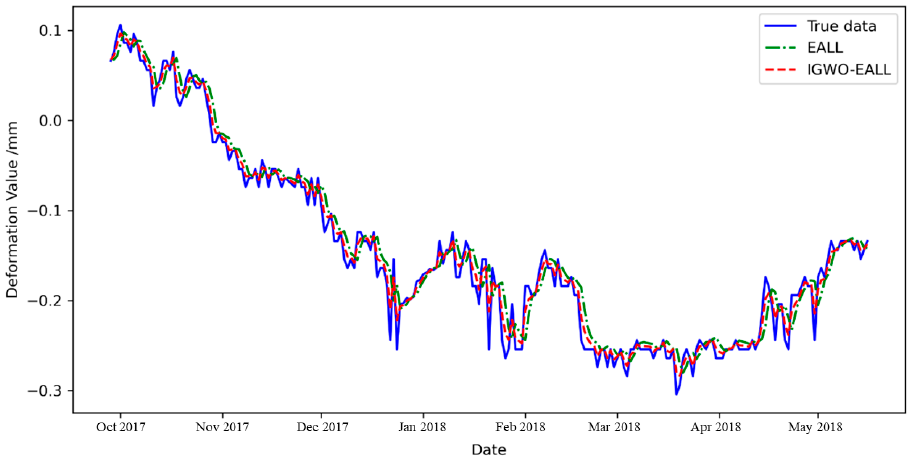
Figure 10. Comparison of prediction results between IEALL and EALL.